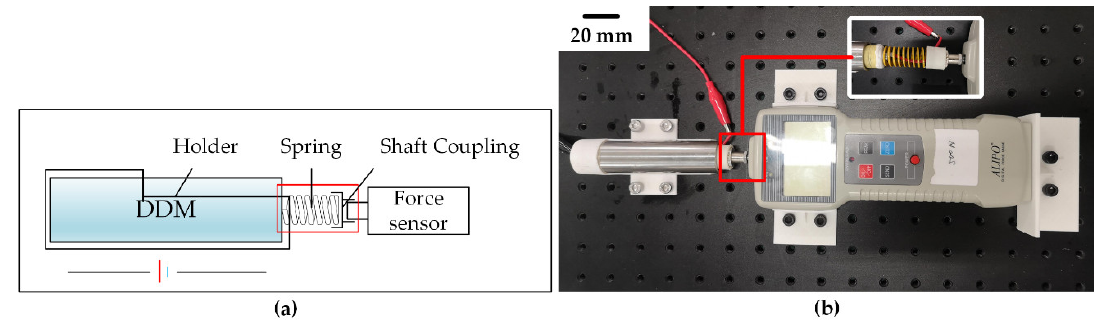
Figure 5. Force characteristics test bench: ( a ) Schematic of the force characteristics testing system, and ( b ) force characteristics test site.